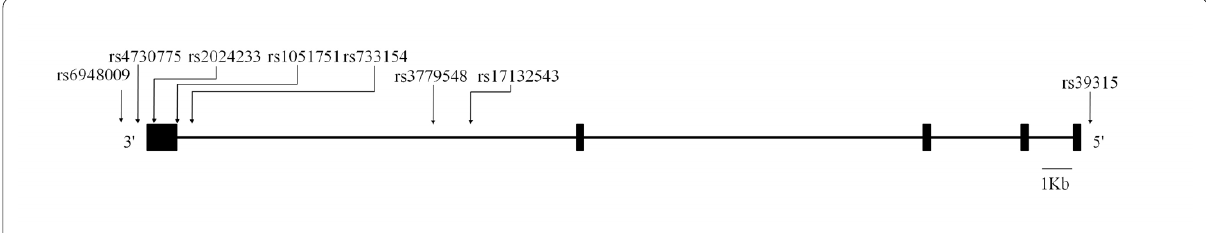
Figure 1 Gene map and single nucleotide polymorphisms (SNPs) in the WNT2 gene on chromosome 7q31.2 . Exons are marked with boxes. The coding regions are black boxes. The first nucleotide is denoted as +1. The arrow indicates the location of each